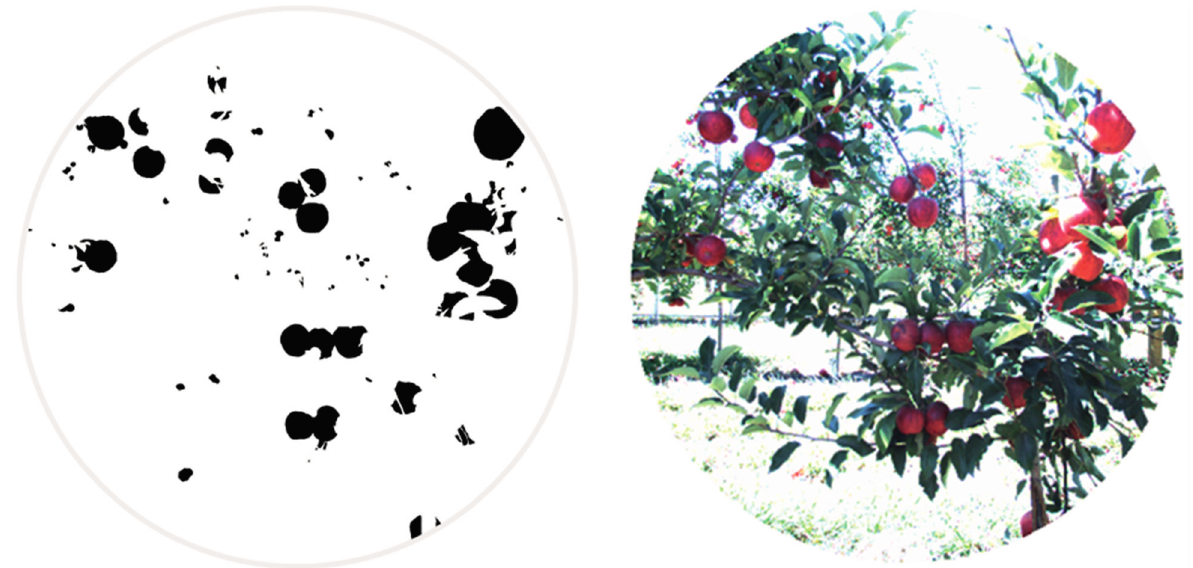
Figure 17. Pixel-based masking for apples.